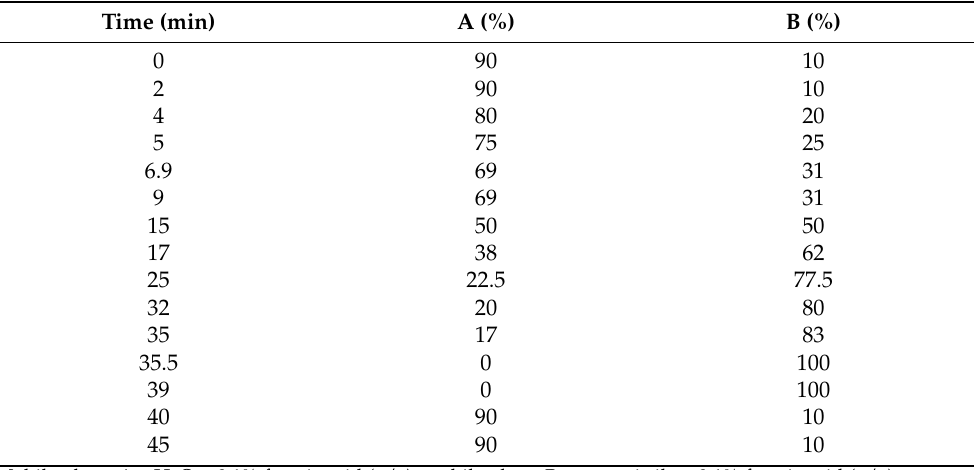
Table 1. UHPLC-MS mobile-phase gradient elution